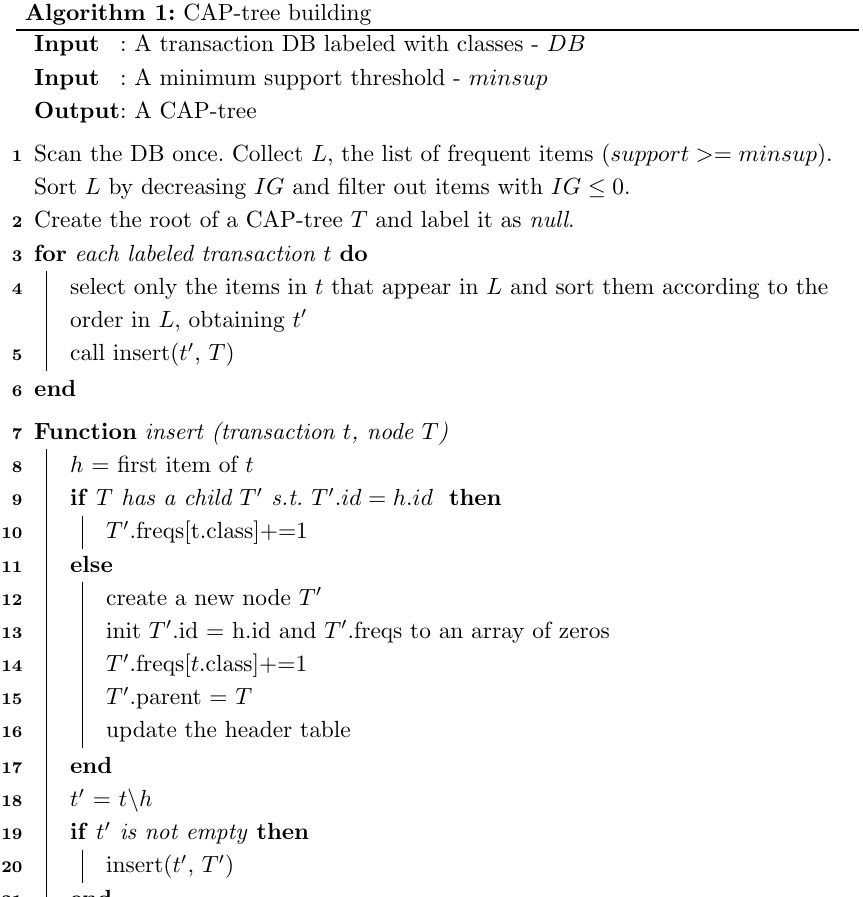
Algorithm 1: CAP-tree